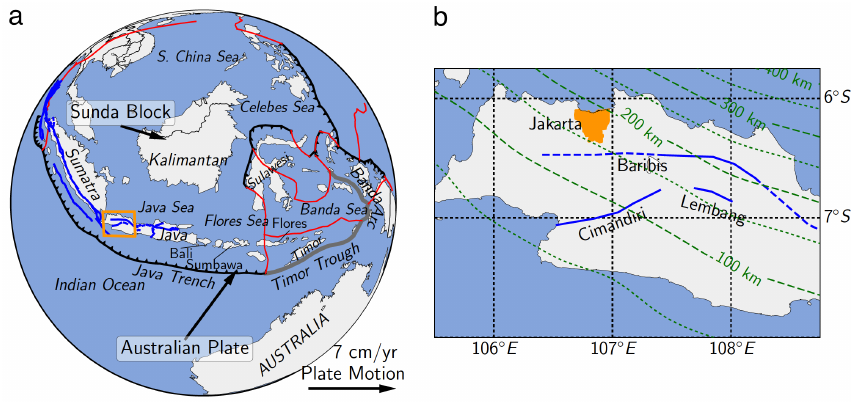
Figure 1. ( a ) Simplified tectonic setting of the Indonesian region and ( b ) western Java, with more detail of the inset area indicated in ( a ). The study area is the orange shaded area in ( b ). Motion of the Australian Plate at a rate of 7 cm a year toward the Eurasian Plate is indicated by a black arrow. Major faults are indicated by blue lines, while black toothed, red and green dashed lines denoted subduction, microcontinent boundaries, and Benioff countours, respectively. The blue dashed-line indicates the continuation of the Baribis fault to the west and east as mentioned in Simandjuntak & Barber